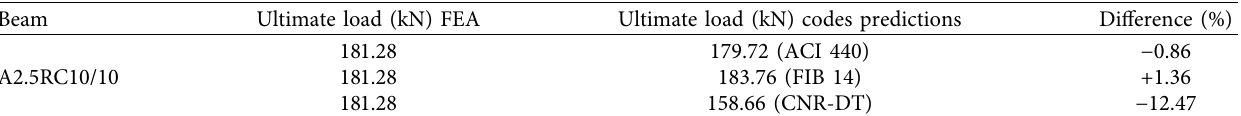
Table 10: Comparisons between the FE results and the codes predictions of the ultimate load at failure for beam A2.5RC10/10.